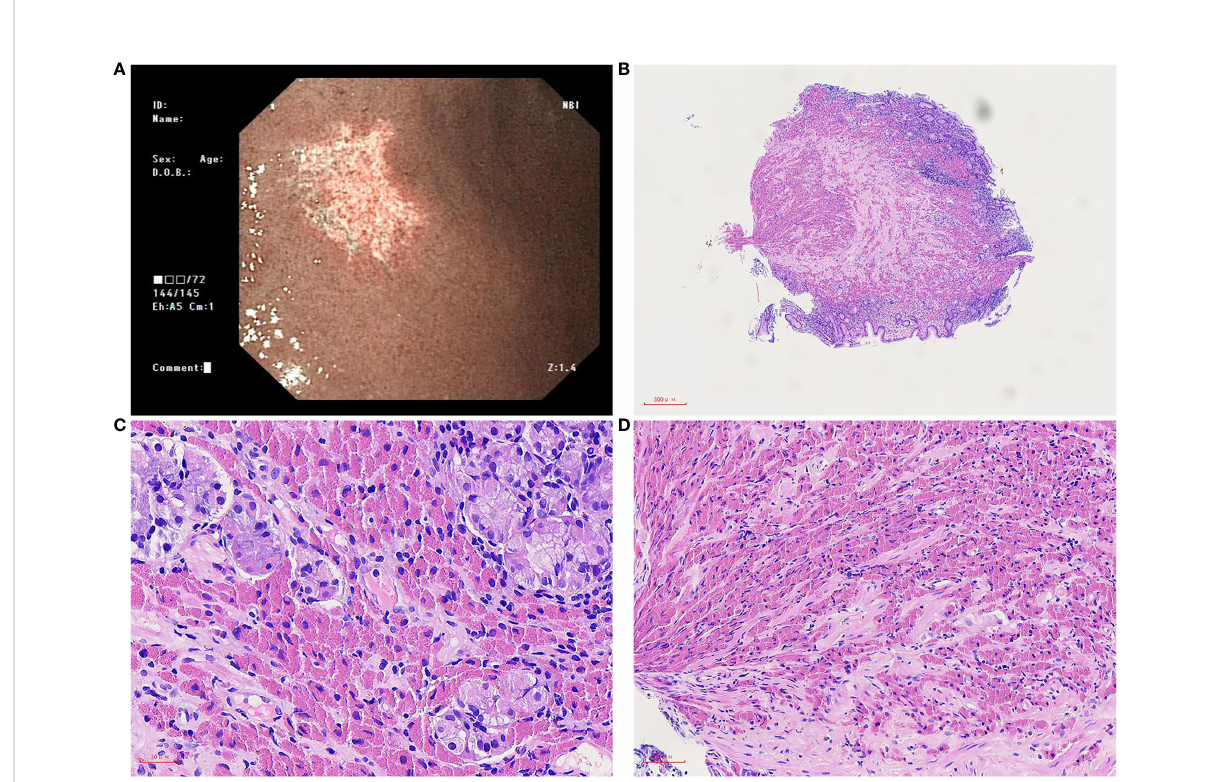
FIGURE 1 Microscopic of gastroscopy biopsy tissue. (A) Gastroscopy showed a piece of irregular whitish focus in the big bend of the gastric antrum. (B) On low power, the gastric mucosa is mildly chronic in fl ammation, mildly active with erosion, and a large amount of eosinophilic sub-stance deposits in the stroma, 40×. (C) On medium power, the inherent glands of the stomach were destroyed, a few remained glands, and a large number of tissue cells containing crystals in the stroma were in fi ltrated, 200×. (D) On high power, needle crystals in cells,